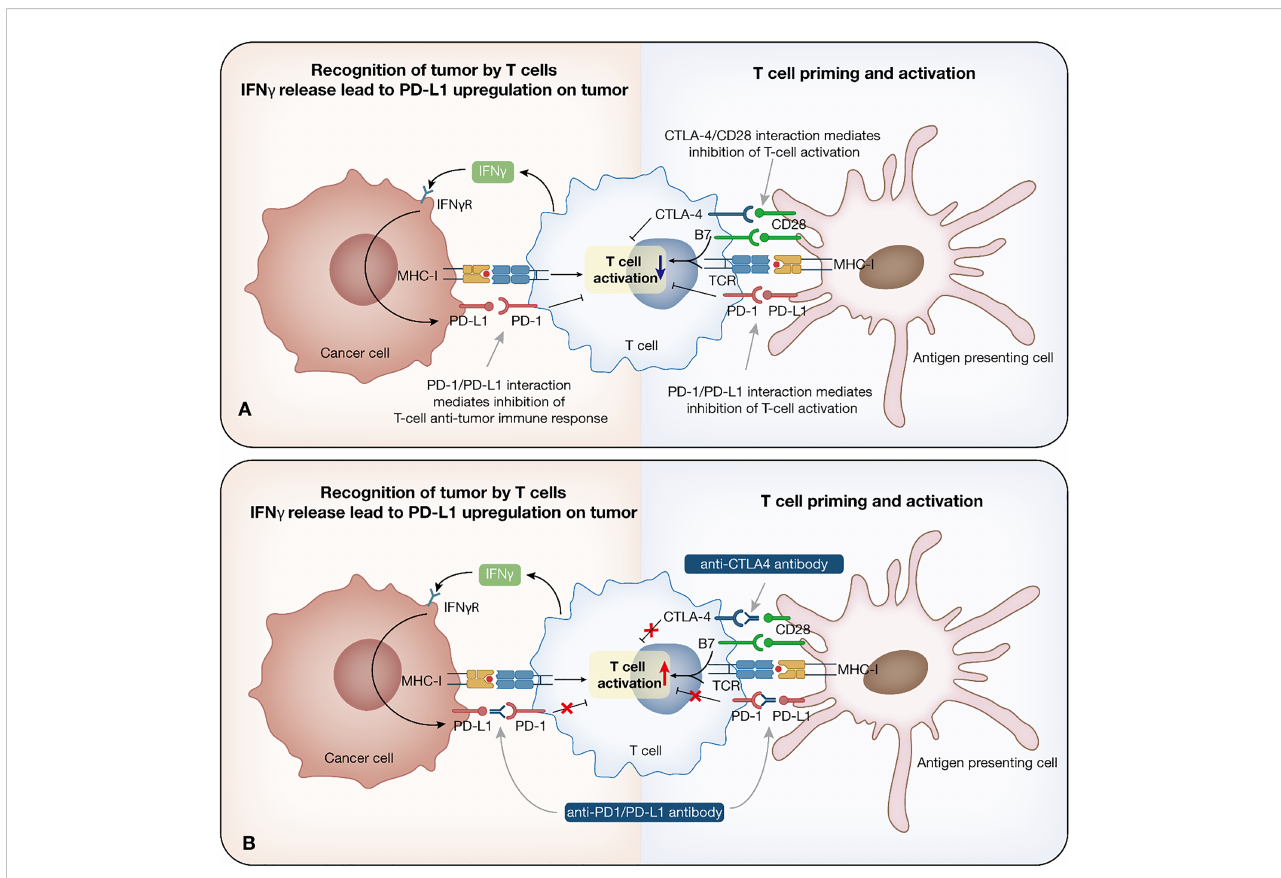
FIGURE 1 Immune checkpoint inhibitor therapy. Immune response to cancer and relationship among cancer cells, T cells and antigen presenting cells. (A) Tumor cells are recognized by the intrinsic immune cells. Once recognized, immune cells trigger initial intrinsic immunity and IFN secretion, promoting chemokines production, and the recruitment of immune cells. Mature DCs take up tumor antigens, which fi nally presented as MHC-I antigenic tumor peptides complex, migrate to the draining lymph nodes, where initial tumor-speci fi c Th1 CD4 + T cells and CTLs are induced by antigen cross- presentation. IL-2 and IL-15 help to maintain CTLs production and viability. (B) Mechanism of anti-PD-1/PD-L1/CTLA-4 antibody. PD-1 is expressed on T cells, while PD-L1 is expressed on tumor cells. These two form the PD-1/PD-L1 axis that mediates T cell function inhibition. The function of anti-PD-1/ PD-L1 antibodies lies in restoring the T cell effect by blocking the PD-1/PD-L1 interaction. CTLA-4 on T cells binds to B7 ligand on the APC, leading to immunosuppression. Anti-CTLA-4 antibodies inhibit the binding between CTLA-4 and B7, which prolongs T cell activation, restore T cell proliferation, and establish an immune response to tumor-associated antigens. IFN, interferon; DC, dendritic cell; MHC-I, major histocompatibility complex class I; CTL, cytotoxic T lymphocyte; APC, antigen-presenting